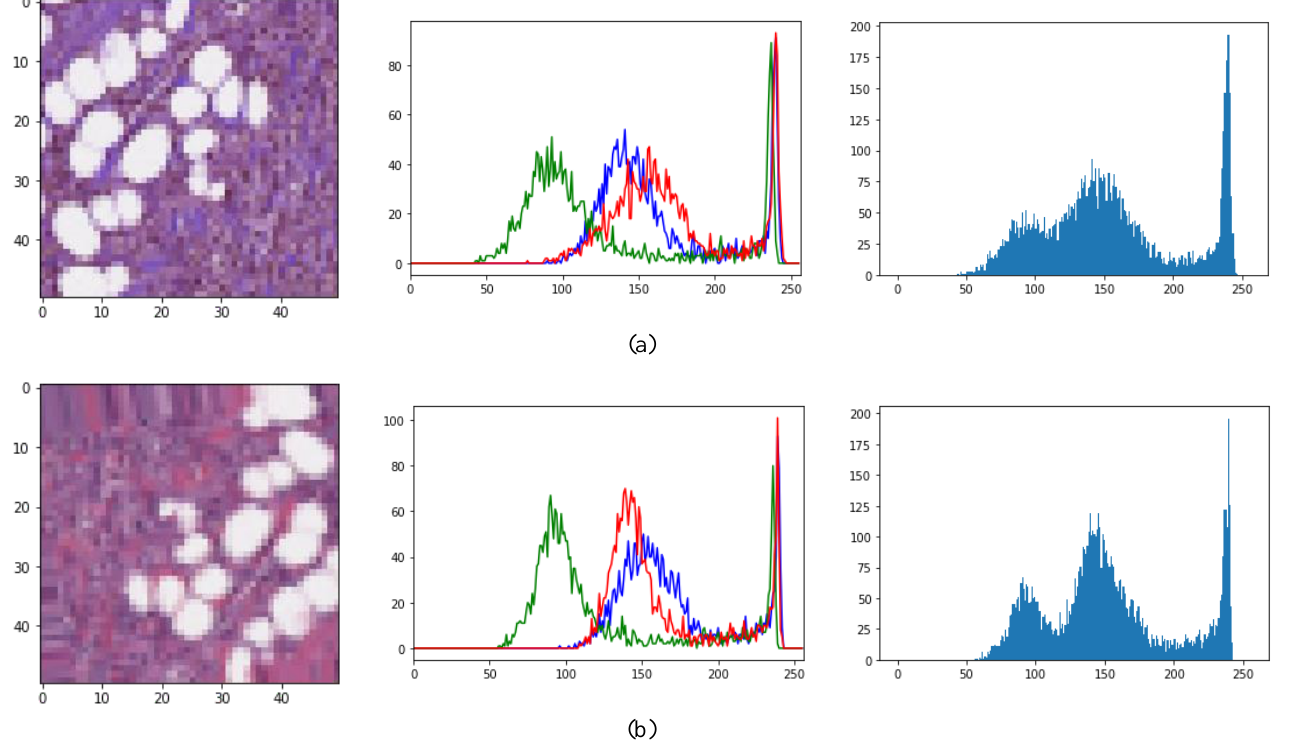
Figure 1. Geometric augmentation’s effect on the image representation: (a) the original image without any changes and the RGB histogram and the overall histogram of the image, (b) the geometric augmentation’s effect on the same